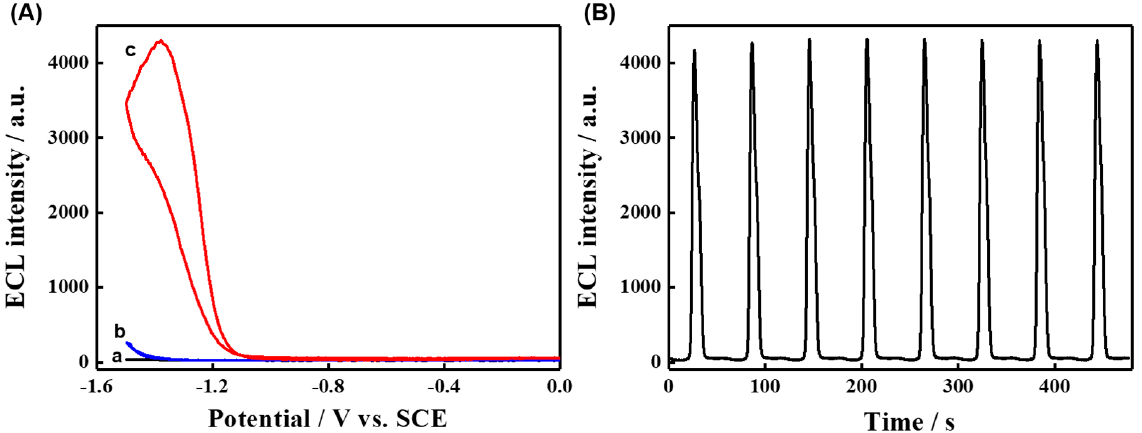
Figure 6. ( A ) ECL potential curves of TCPP (a), (S)-BINOL (b), and TCPP-Zn-(S)-BINOL (c). ( B ) ECL behaviors of TCPP-Zn-(S)-BINOL/GCE during a continuous potential scan between − 1.5 and 0.0 V.